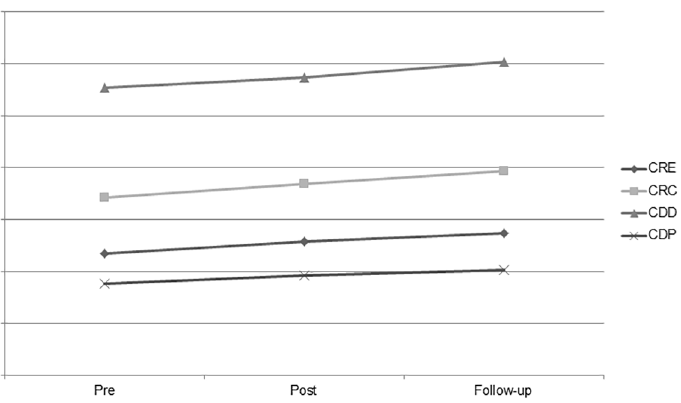
Figure 1. Changes of metacognitive functions at pre-, post-treatment, and 3-month follow-up assessment. Note. CRE = ability to recognize emotional states; CRC = ability to understand causal relationships; CDD = ability to judge the distance of objects; CDP = ability to ponder situations and